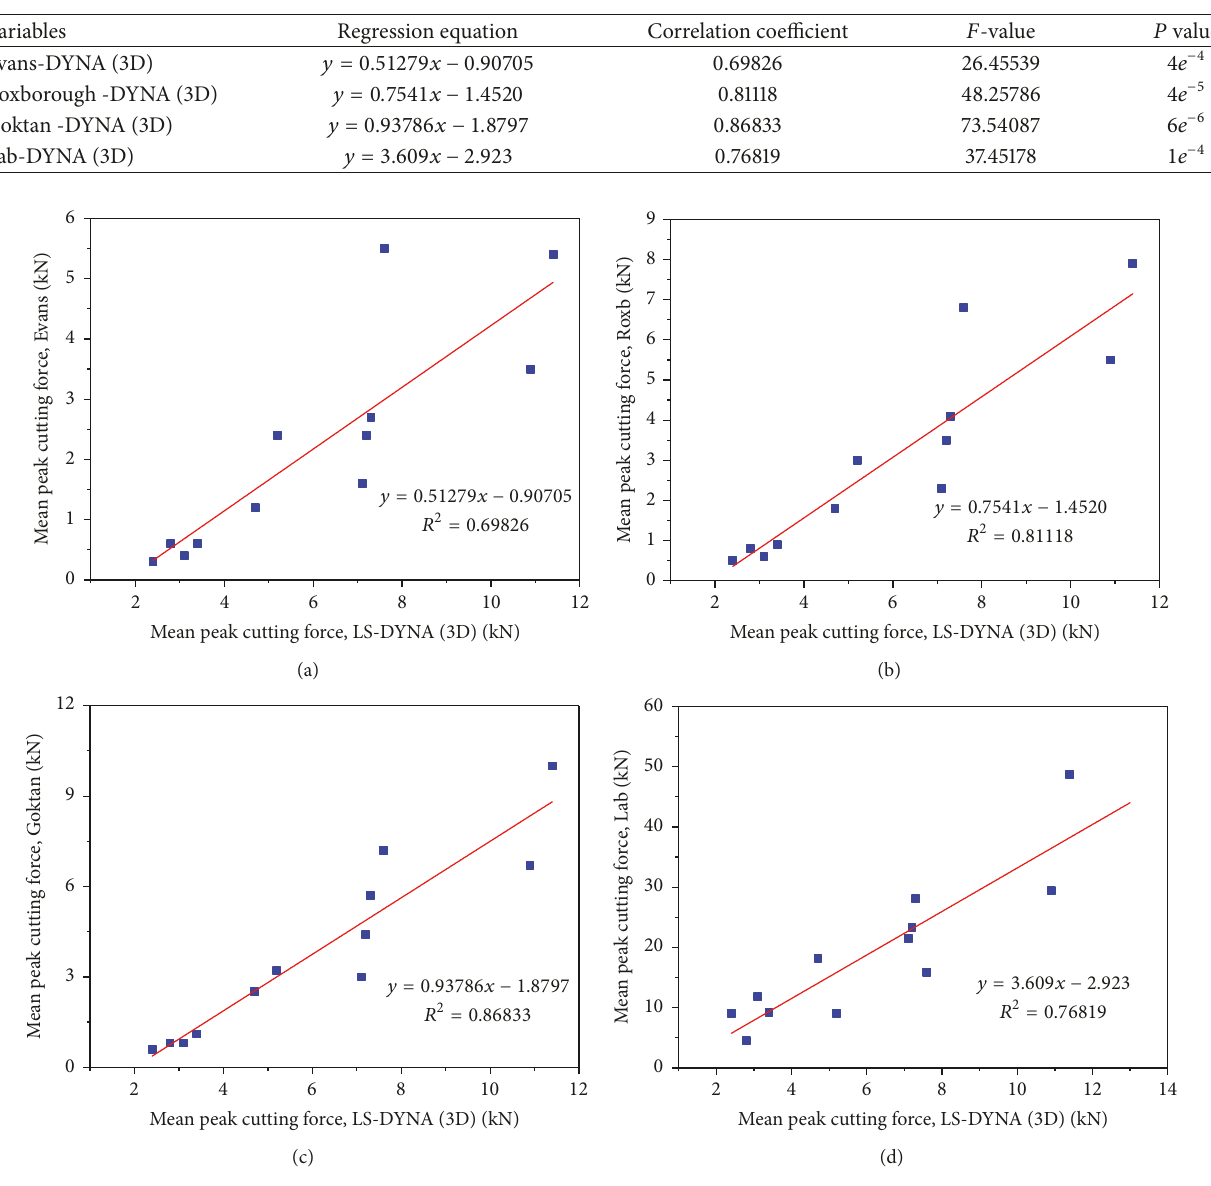
Figure 11: The relationship between numerical and theoretical studies and the relationship between numerical and experimental studies: (a) LS-DYNA (3D) and Evans’ theory, (b) LS-DYNA (3D) and Roxborough’s theory, (c) LS-DYNA (3D) and Goktan’s theory, and (d) LS-DYNA (3D) and experimental